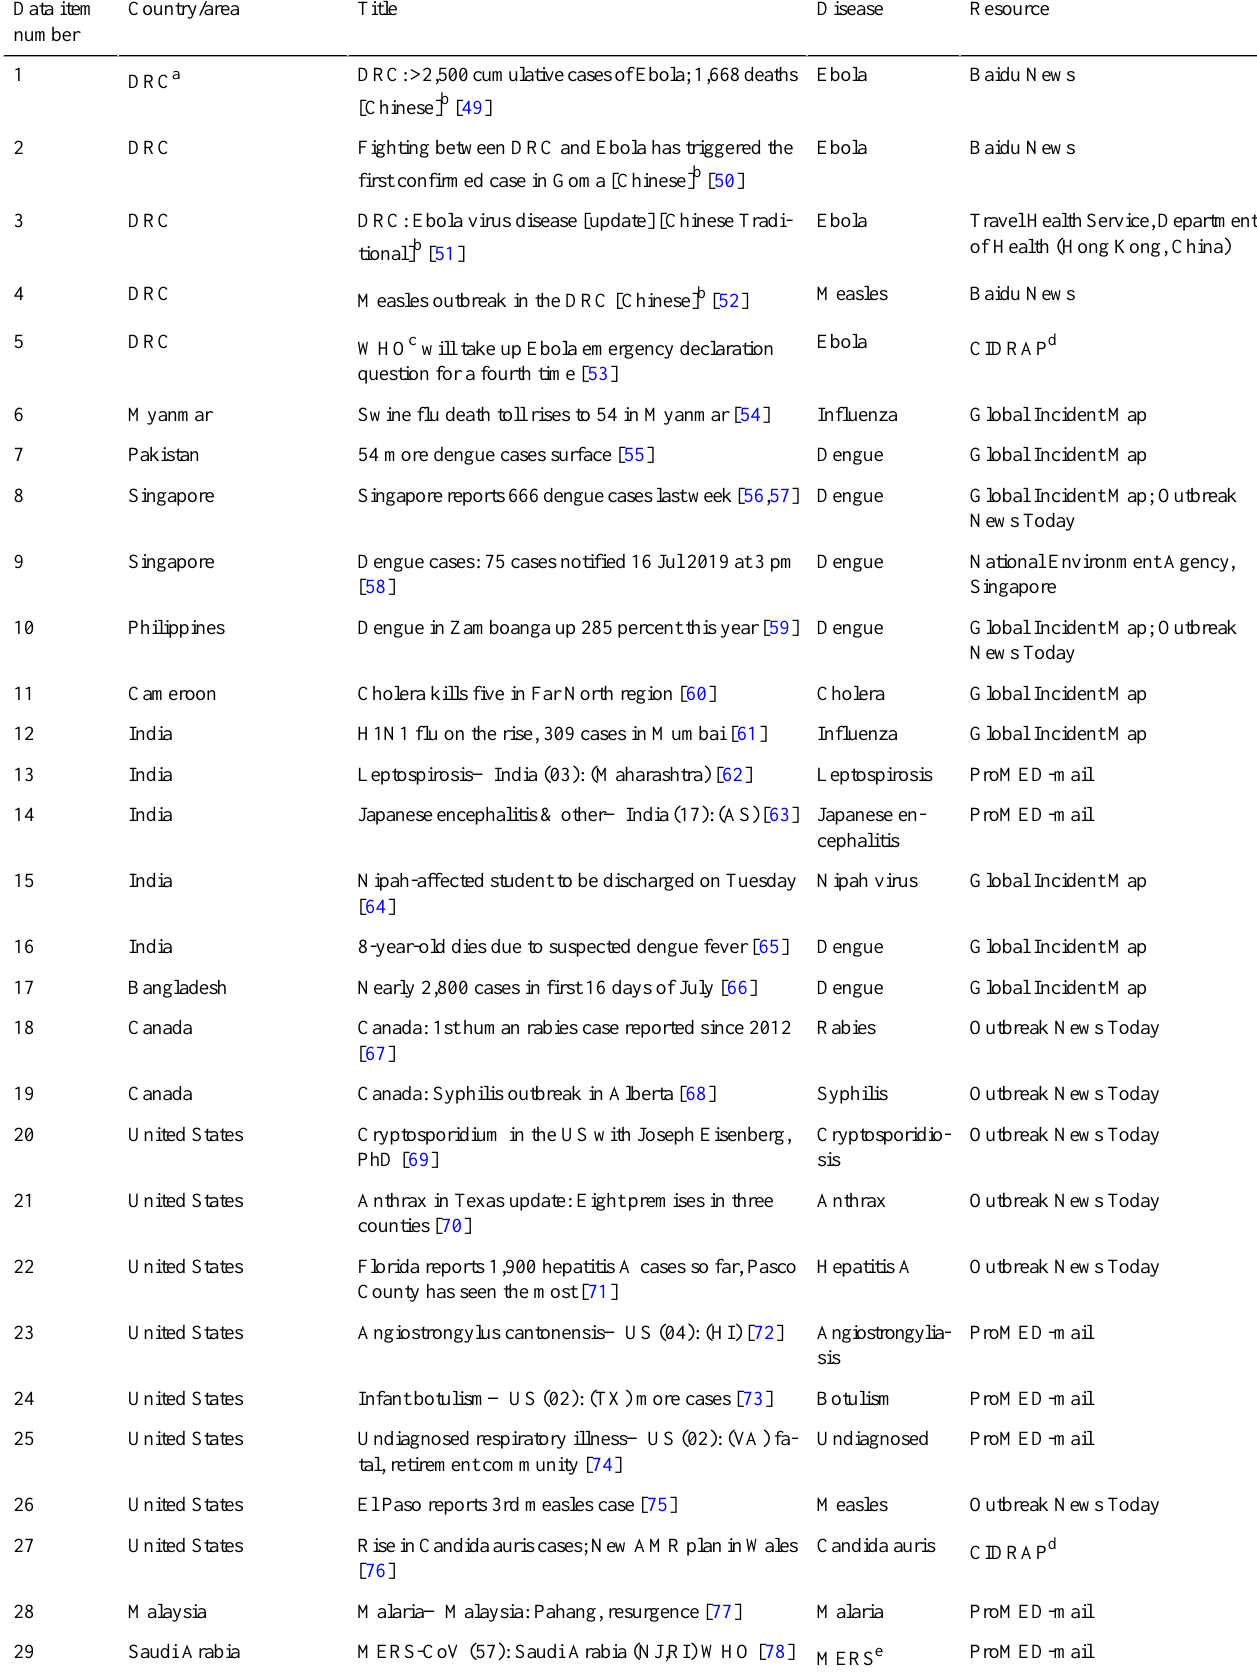
Table 3. Epidemic information collected on July 16, 2019. ResourceDiseaseTitleCountry/areaData